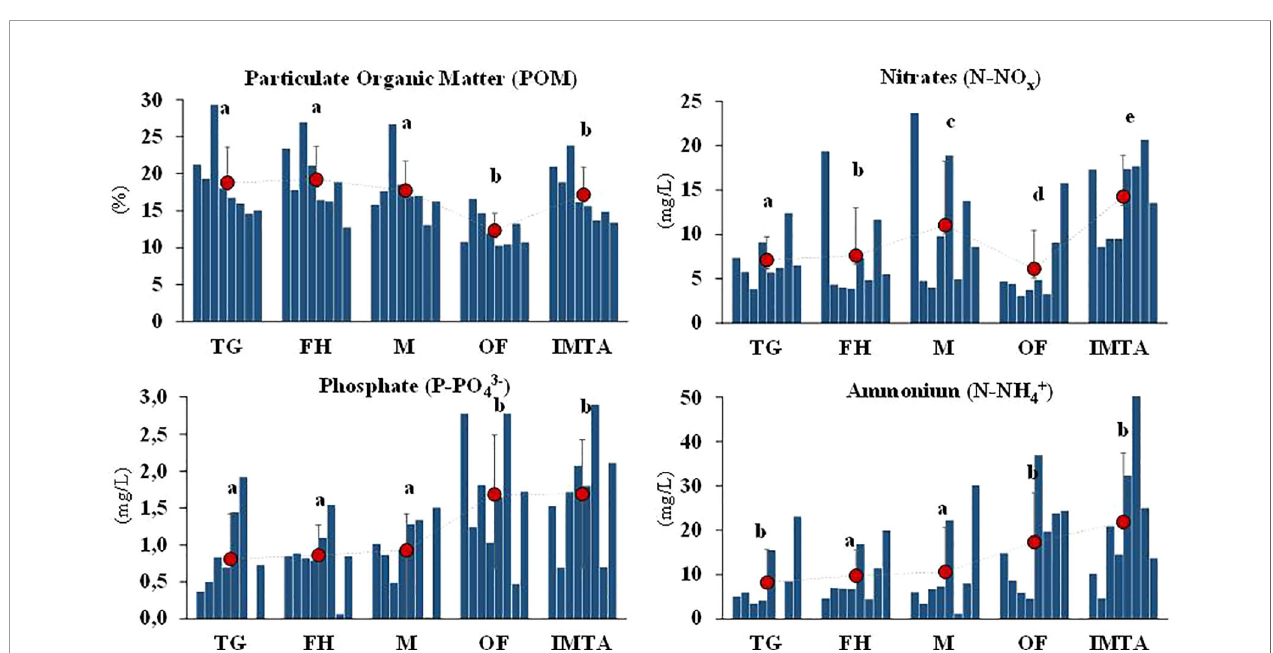
FIGURE 6 | Environmental parameters [POM (%), NO x (µmol/L), PO 43- (µmol/L), NH 4+ (µmol/L)] registered at each sampled location throughout the duration of the experiment, in the Ria de Aveiro. Red dots represent the mean average with the respective standard deviation. Letters represent statistically signi fi cant differences. TG, Tide Gauge; FH, Fishing Harbour; M, Marina; OF, Oyster Farm; IMTA, Integrated Multi-Trophic